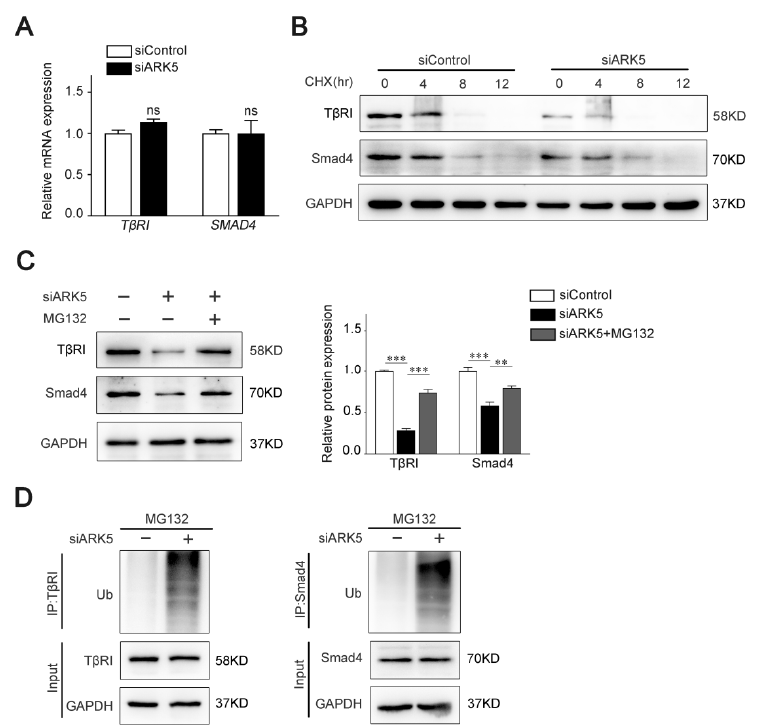
Figure 4. Knockdown of ARK5 promotes the degradation of T β RI and Smad4 at the protein level. ( A ) Quantitative PCR for T β RI and Smad4 in control and ARK5-knockdown LX-2 cells. ( B ) Western blot for T β RI and Smad4 in control and ARK5-knockdown LX-2 cells treated with CHX (50 µ g/mL) for the indicated time. ( C ) Western blot for T β RI and Smad4 in control and ARK5-knockdown